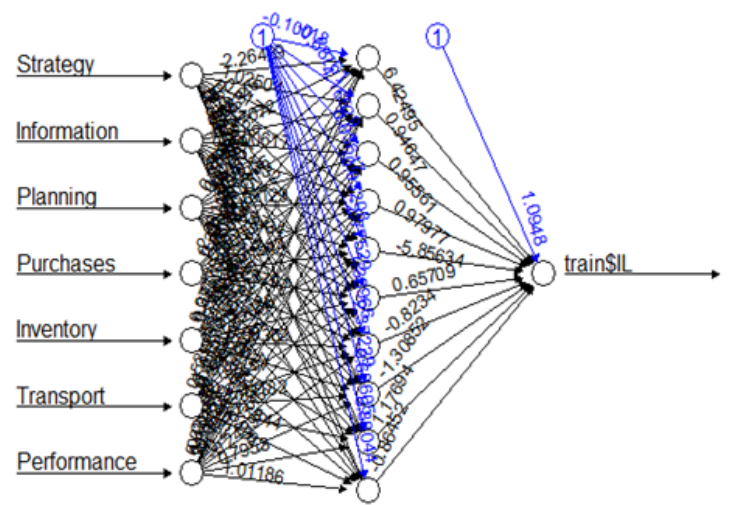
Figure 2. Multilayer perceptron neuronal network model of heterogeneous weights